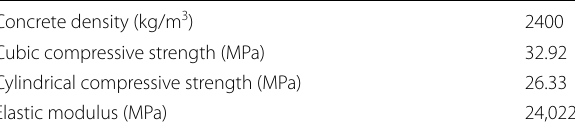
Table 10 The mechanical behavior of